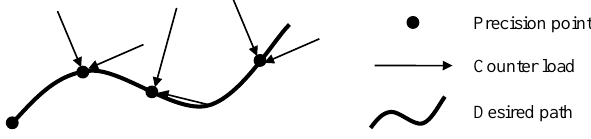
Figure 4. Path with counter loads (Pedersen et al.,